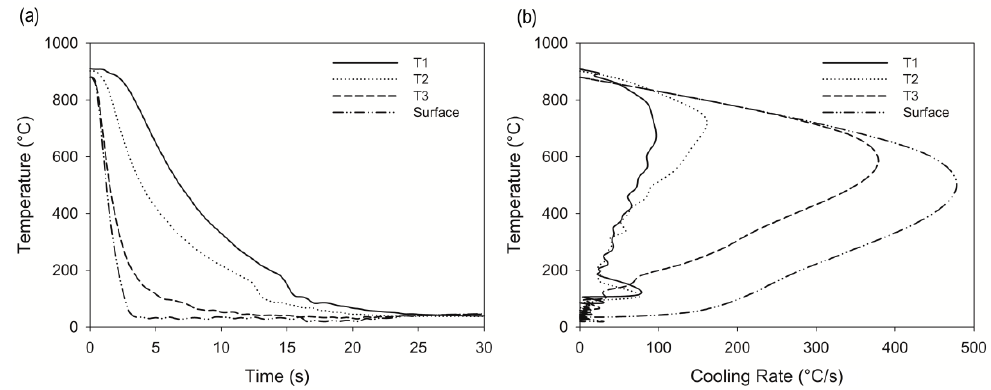
Figure 5. Cooling curves ( a ) and cooling rate curves ( b ); T1- ½ thickness, T2-¼ thickness, and T3- 1 mm below the surface .